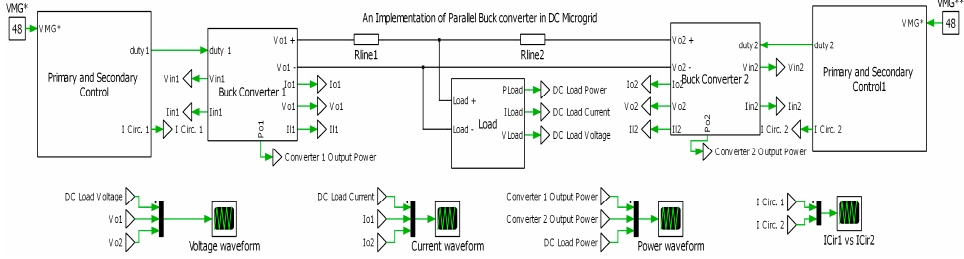
Figure 6. Complete simulation model of parallel Buck converters in DC Microgrid in